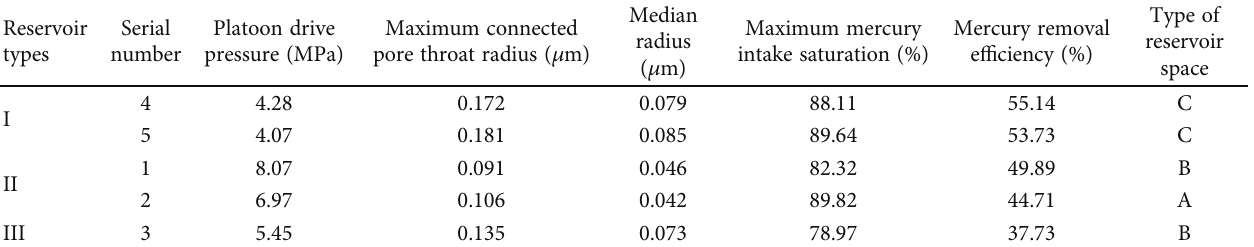
Table 2: Microscopic pore structure characteristic parameters of the III+IV oil group in Nanyishan Oil fi eld.